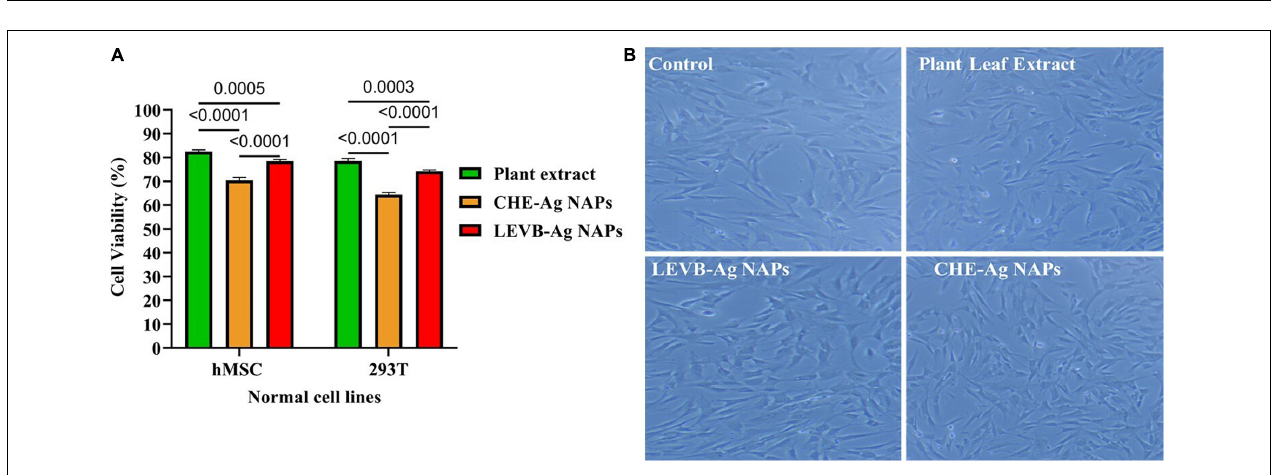
FIGURE 9 | (A) Cytobiocompatibility of LEVB-Ag NAPs with hMSC and 293T cell lines in comparison to plant leaf extract and CHE-Ag NAPs. (B) Inverted microscope images of untreated (control) and treated hMSC cell lines with biosynthesized LEVB-Ag NAPs, plant leaf extract, and CHE-Ag